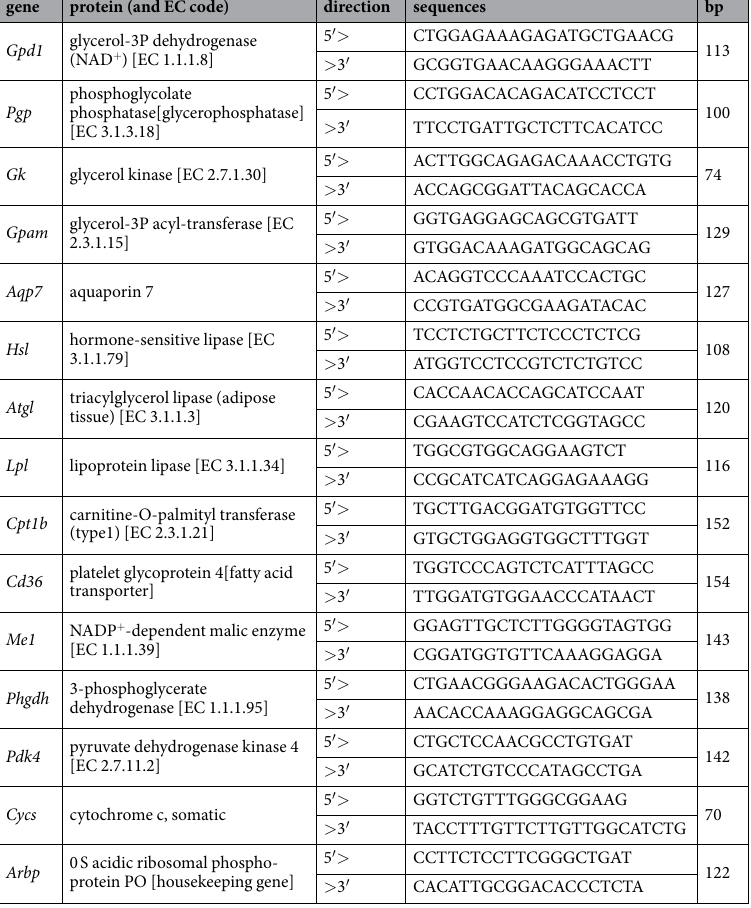
(5) The often large variability of some of the label fraction measurements, resulting in statistical uncertainty. (6) The need to use “parallel” wells with no label for the measurement of protein expressions. (7) Too many interde- pendent results showing complex interactions, which forced us to limit the data presented and discussed here. The results of our study support an active role of WAT in the handling of glucose, probably helping maintain glycaemia. The main findings were: (A) Glucose uptake was higher than the actual cell energy needs, since even in the absence of insulin, the glycolytic production of lactate apparently provided sufficient ATP to sustain the adipocyte under practically anaerobic conditions 33 . This process is characterized by an increased expression of Glut1 (independent of insu- lin 38 ) and the production of lactate 33, 34 , being the main cell energy-sustaining pathway. The regular, and quantita-